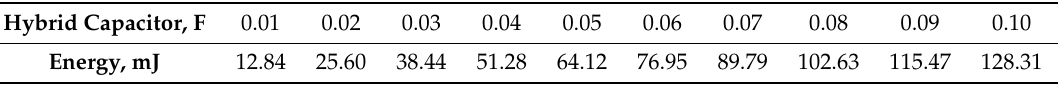
Table 2. Peak usable energy in energy storage near home